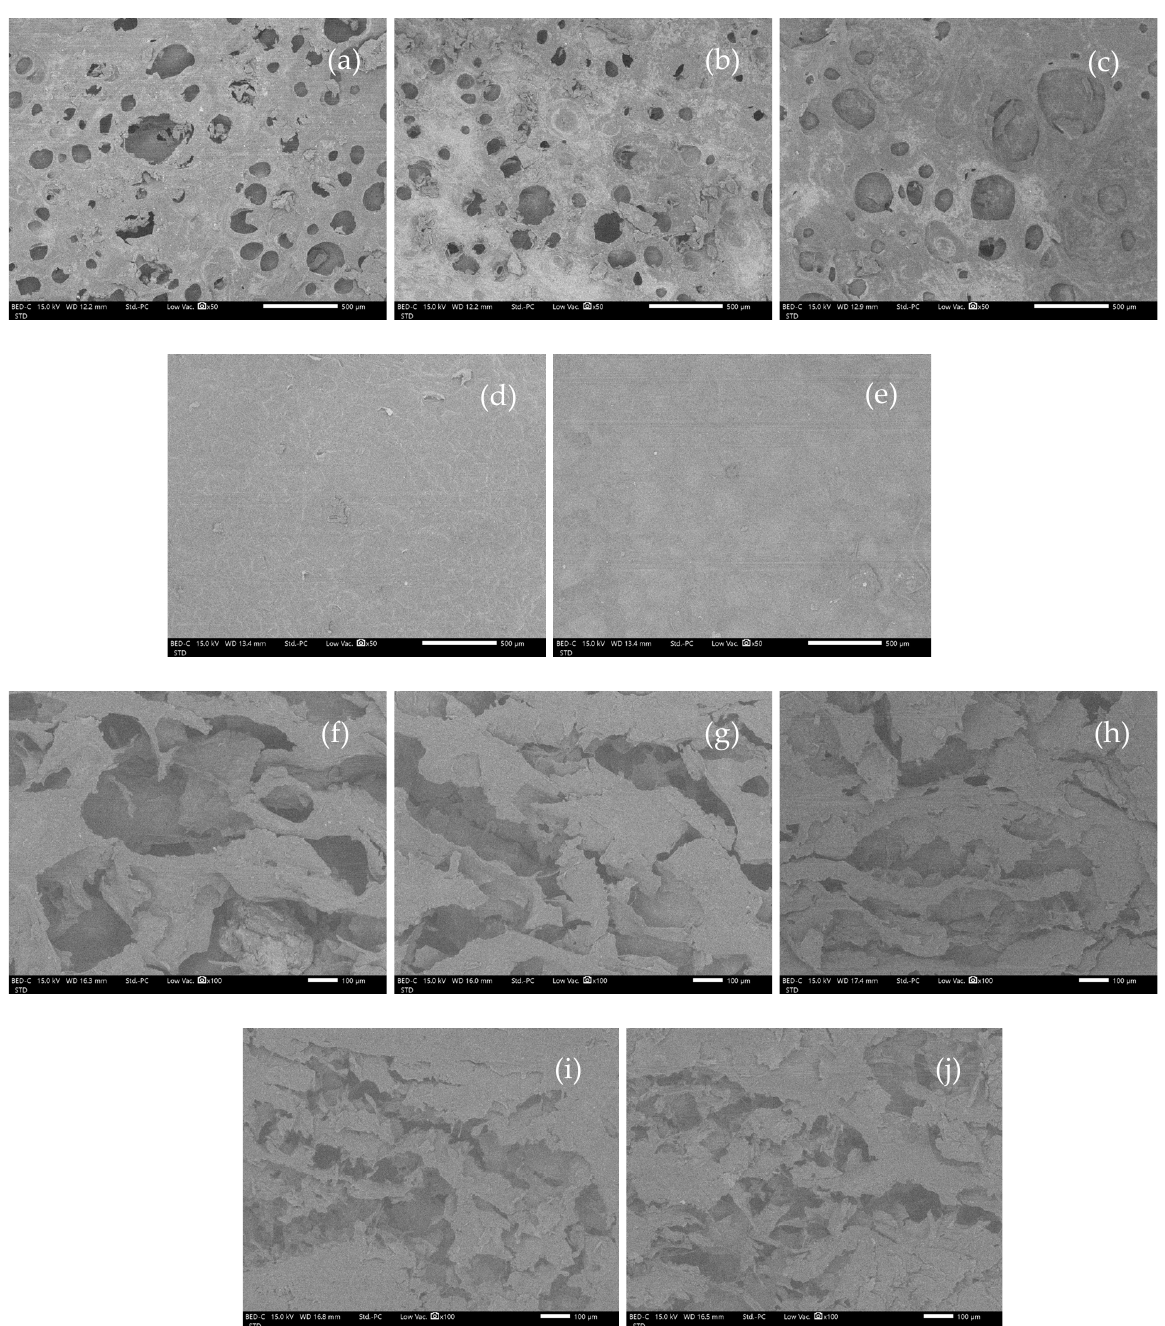
Figure 6. SEM micrographs of the surface and cross section of WHC-based cryogels at 50 and 100 magnifications. ( a ) = surface of C 1 A 0.5 P 0.5 , ( b ) = surface of C 1.5 A 0.5 P 0.5 , ( c ) = surface of C 2 A 0.5 P 0.5 , ( d ) = surface of C 2.5 A 0.5 P 0.5 , ( e ) = surface of C 3 A 0.5 P 0.5, ( f ) = cross-sectional image of C 1 A 0.5 P 0.5 , ( g ) = cross-sectional image of C 1.5 A 0.5 P 0.5 , ( h ) = cross-sectional image of C 2 A 0.5 P 0.5 , ( i ) = cross-sectional image of C 2.5 A 0.5 P 0.5 , and ( j ) = cross-sectional image of C 3 A 0.5 P 0.5